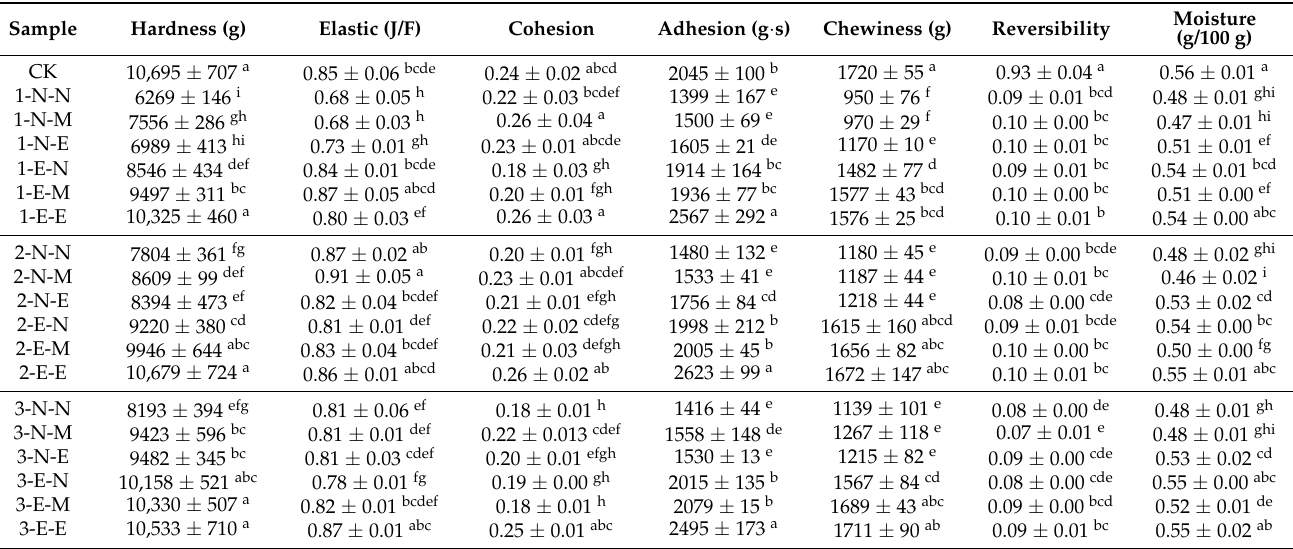
Table 3. Texture properties of Mongolian